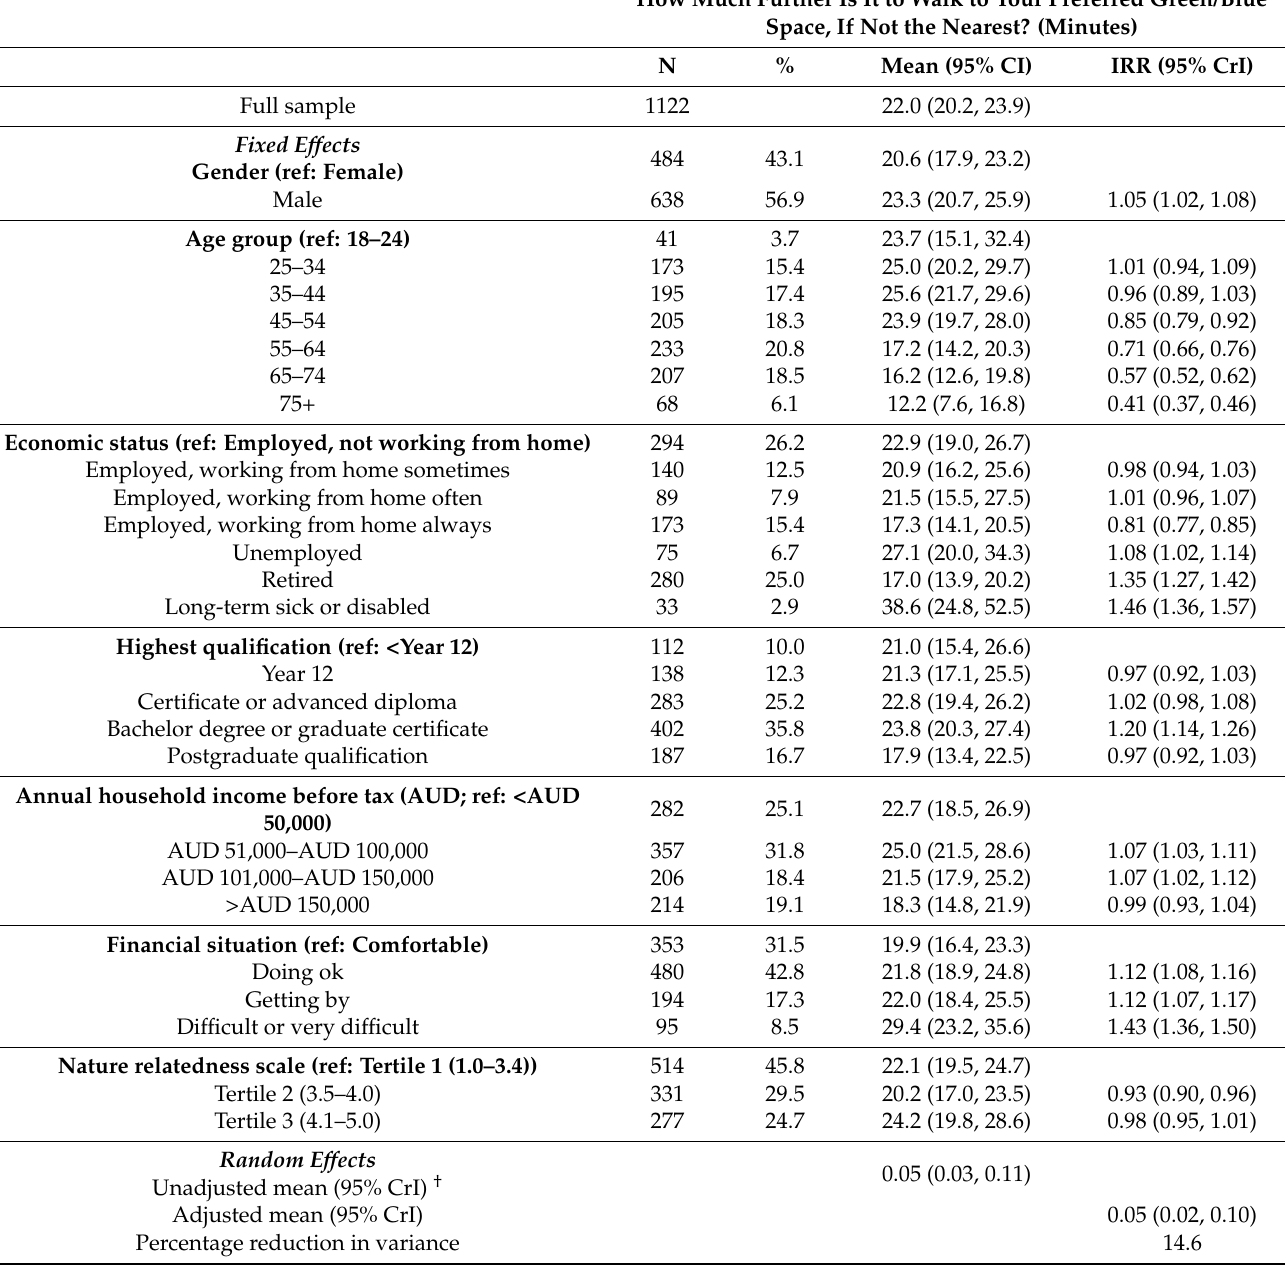
Table 2. Associations with additional walking minutes to the preferred green or blue spaces, if the one nearest is not preferred. How Much Further Is It to Walk to Your Preferred Green/Blue Space, If Not the Nearest? (Minutes) N % Mean (95% CI) IRR (95% CrI) Full sample 1122 22.0 (20.2,